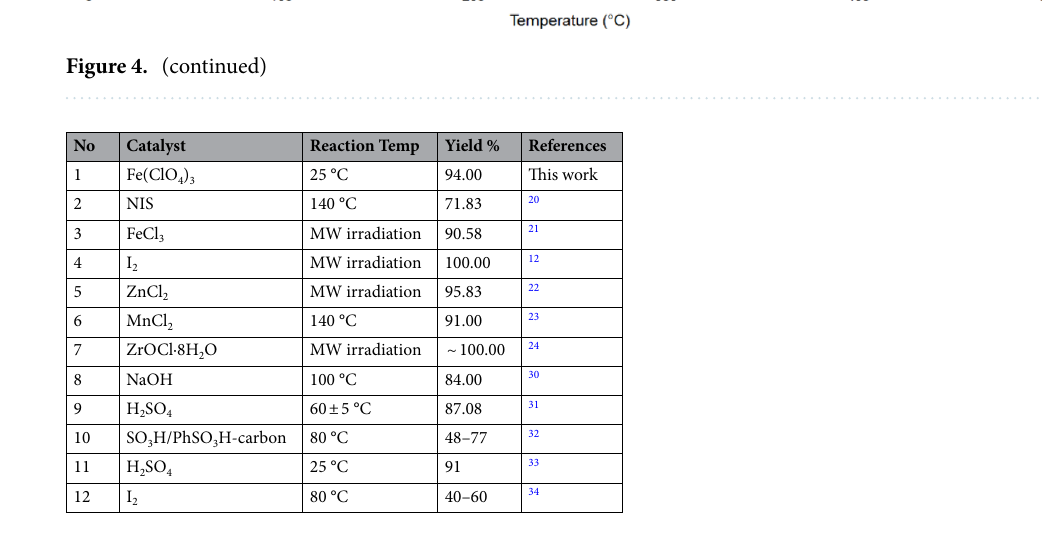
Table 3. Comparison between the yields of cellulose acetate using different catalysts. MW irradiation microwave irradiation in closed teflun cup as reported in leteratures.